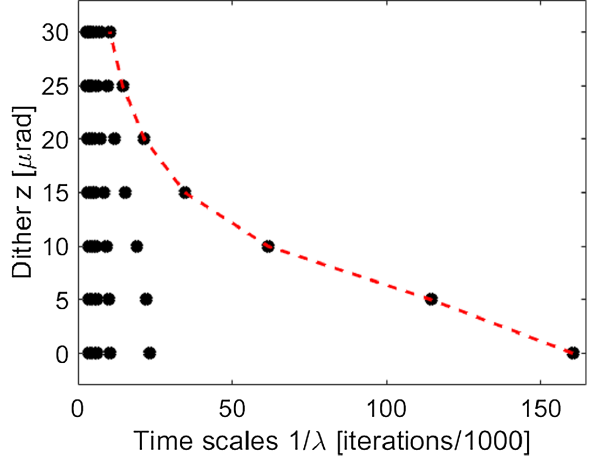
FIG. 7. Timescales of the convergence, determined from the inverse eigenvalues of Q for dithering amplitudes z from 0 to 30 mrad. In all cases we use σ w ¼ 0 . 1 mm. The dashed red line shows the timescale 1 = λ corresponding to the smallest eigenvalue of Q